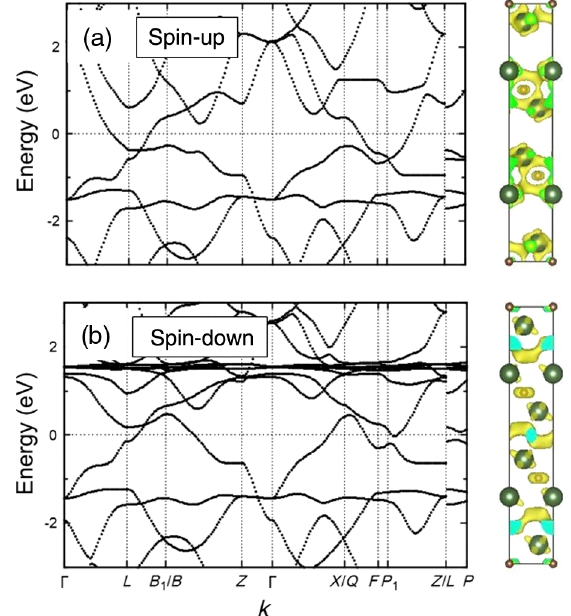
FIG. 7. Calculated energy band and PED isosurface for Er 2 C corresponding to each spin channel ( U ¼ 6 . 7 eV, J ¼ 0 . 7 eV).